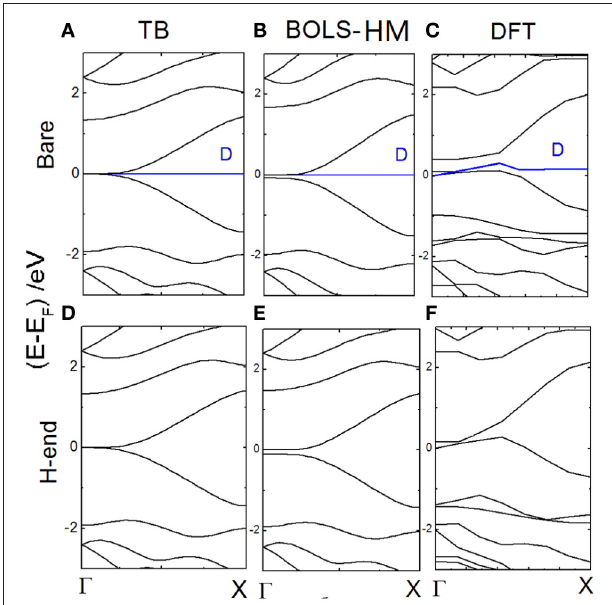
FIGURE 5 | The energy dispersion of bare RecGNR-8 calculated by (A) TB; (B) BOLS-HM; (C) DFT; The energy dispersion of H-end RecGNR-8 calculated by (D) TB; (E) BOLS-HM; and (F) DFT. Reprinted with permission from Zhang et al. [71].